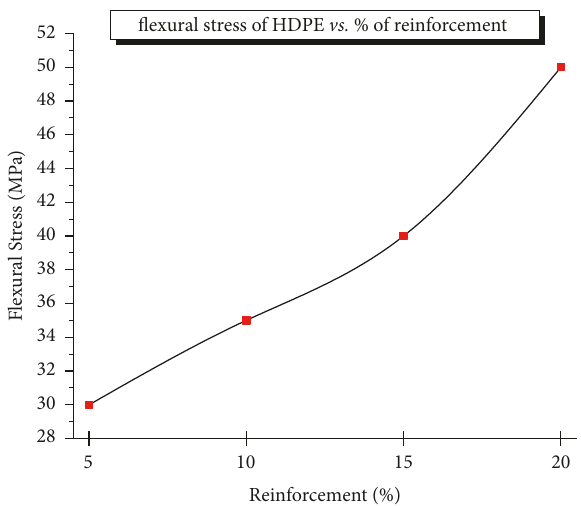
Figure 4: Variation of bending stress with %